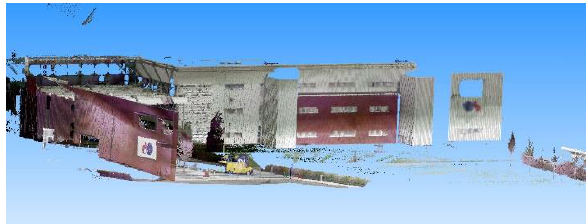
Figure 2. OS Explorer House mesh and point cloud from a Leica MS60 Multistation